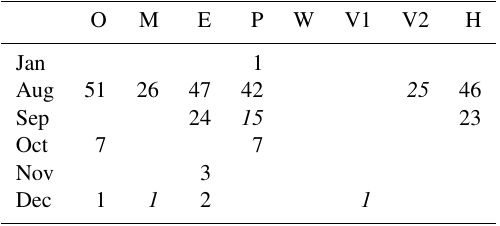
Table 9. Linear, decadal changes in monthly mean T d ( ◦ C) for Bergen-Florida station and for the co-located grid cells of the model estimates between January 1985 and December 1999, significant at a 5% or 10% (italics)